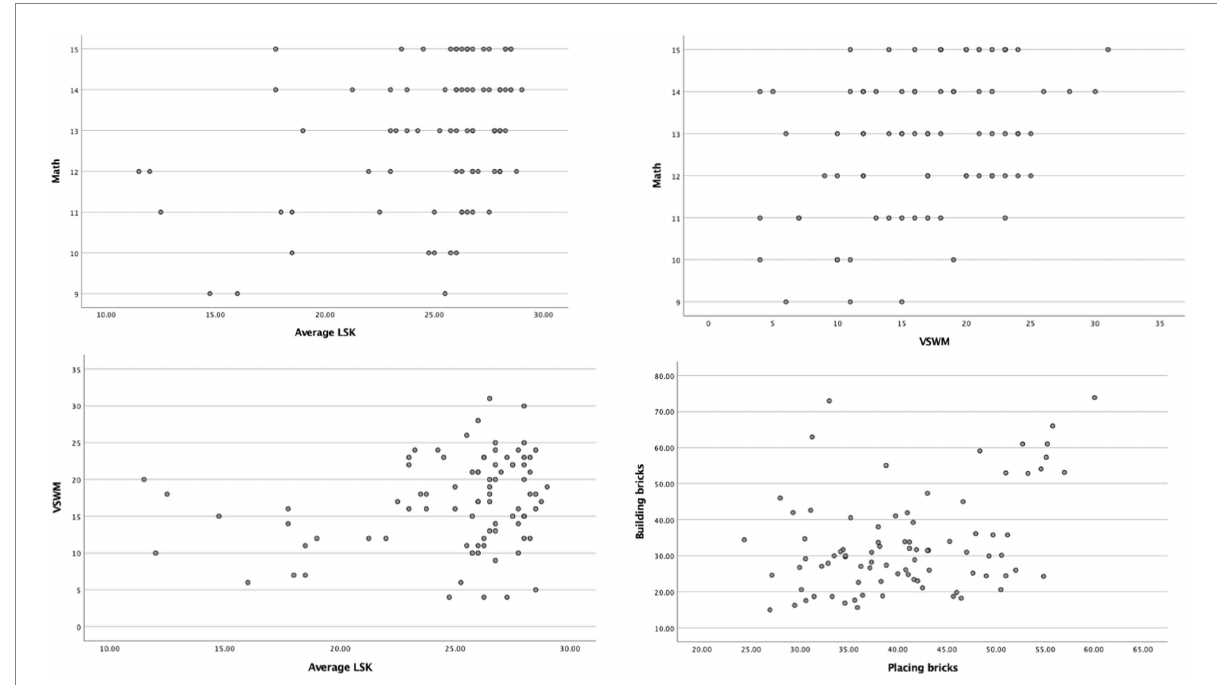
FIGURE 1 Scatterplots of the statistically significant correlations for the whole